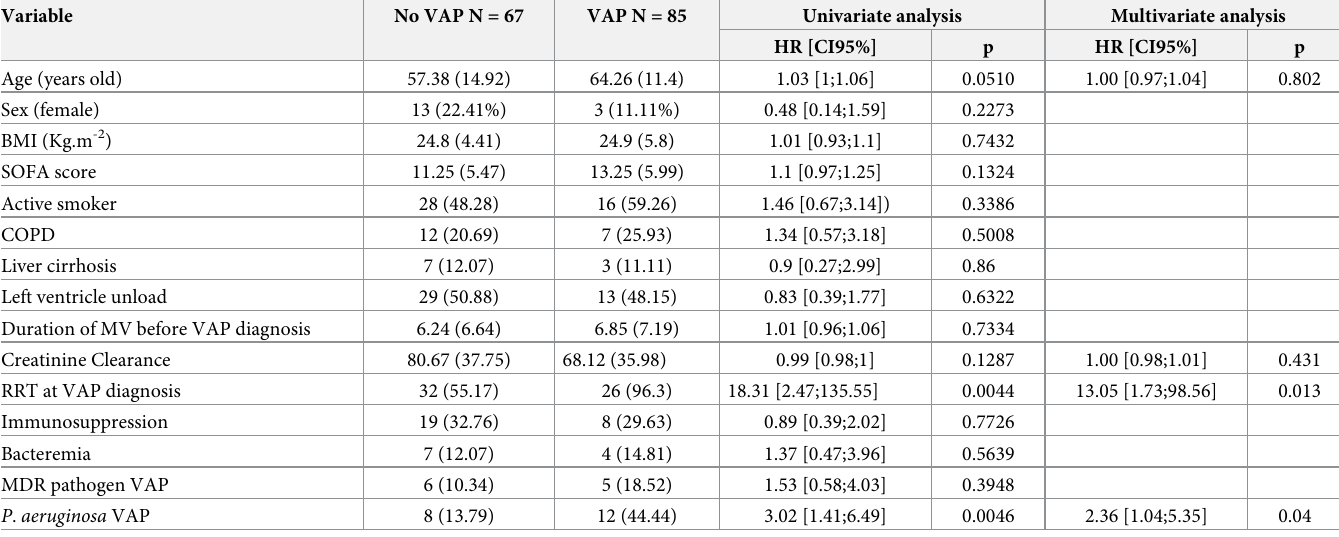
COPD: chronic obstructive pulmonary disease; MV: mechanical ventilation; VAP: ventilator-associated pneumonia; RRT: Renal Replacement Therapy; MDR: multidrug resistant Data are No. (%) of patients or mean value (± standard